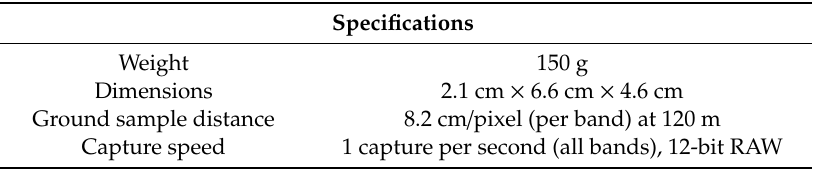
Table 3. Specifications of the MicaSense RedEdge multispectral